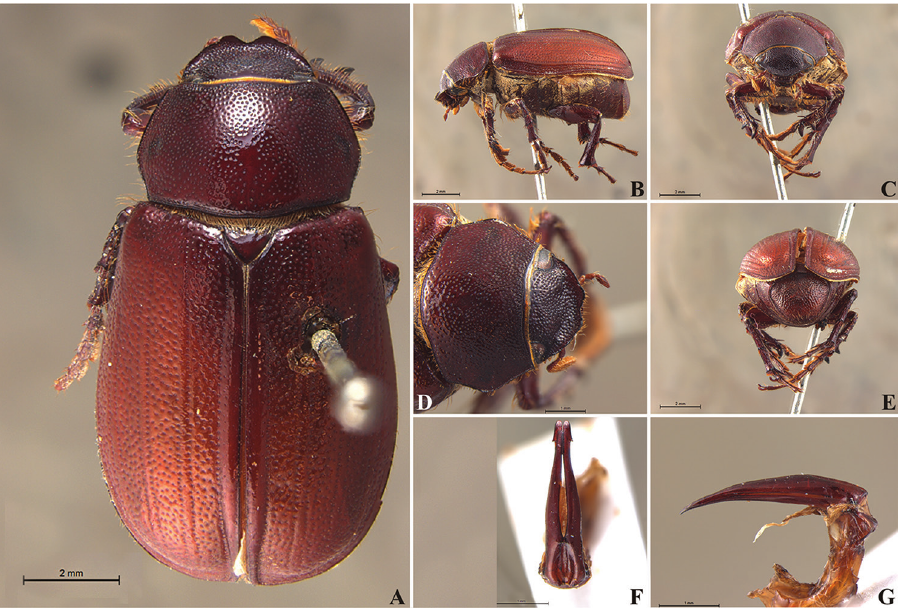
Figure 67. Liogenys pallidicornis Blanchard. A Dorsal view B Lateral view C Frontal view D Clypeus and pronotum E Pygidium F Parameres, dorsal view G Parameres, lateral